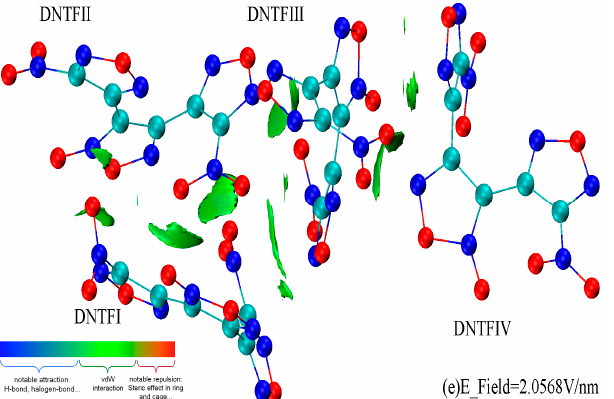
Figure 3. Intermolecular non-covalent interactions among DNTF molecules under different E-fields. The green isosurface represents the 0.01 a.u. region.